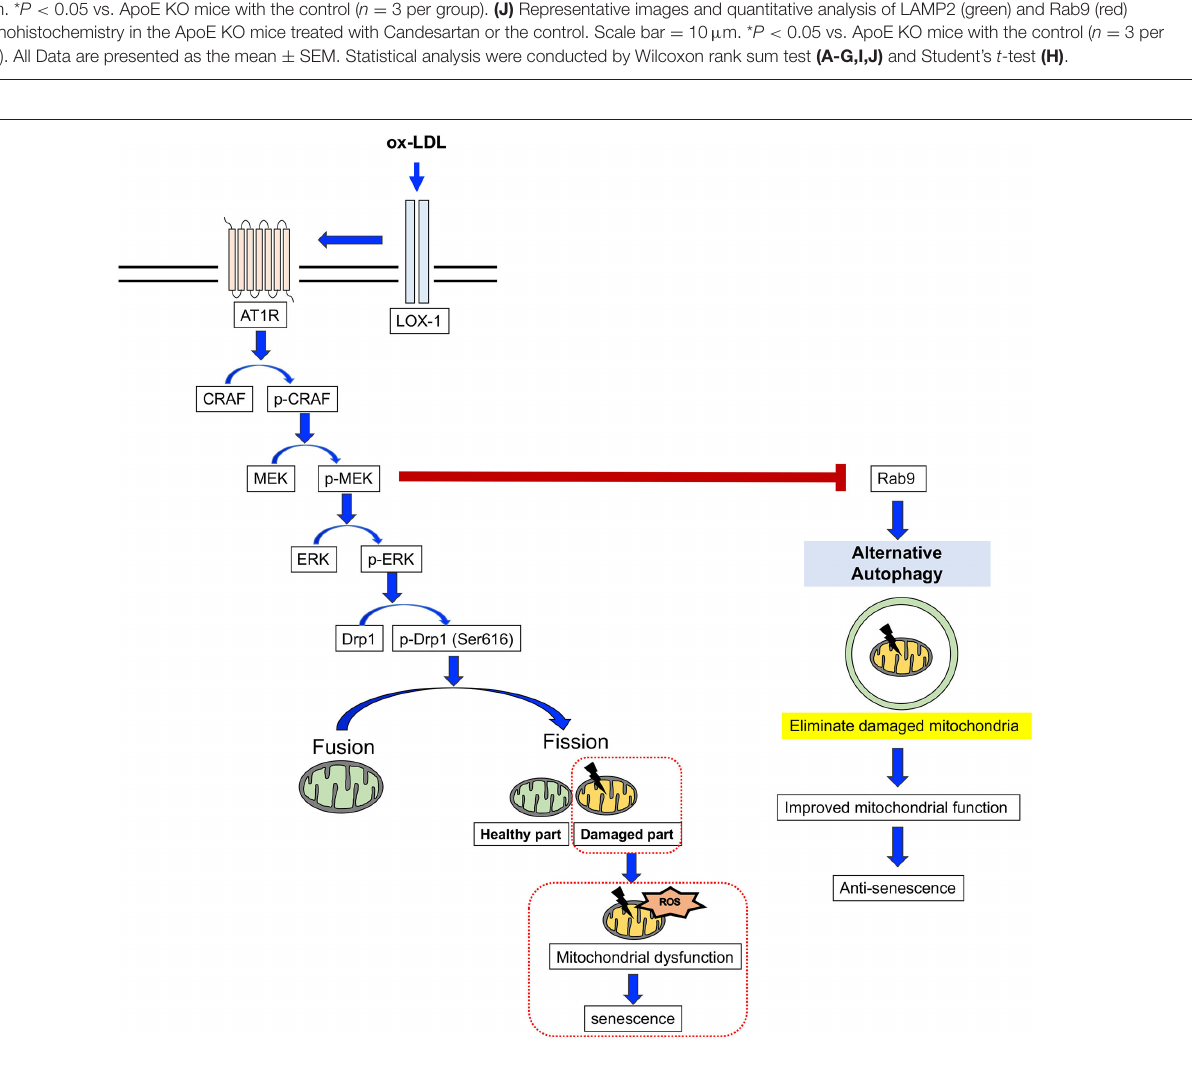
FIGURE 8 | Candesartan or the control. Scale bar = 1 µ m. * P < 0.05 vs. ApoE KO mice with the control ( n = 3 per group). (B) Immunoblots and quantitative analysis for Drp1, p-Drp1 (Ser616), p-Drp1 (Ser637), Mfn1, Mfn2, Opa1, and α -tublin in ApoE KO mice treated with Candesartan or the control. * P < 0.05 vs. ApoE KO mice with vehicle ( n = 3 per group). (C) Relative mitochondrial H 2 O 2 production in ApoE KO mice treated with Candesartan or the control. * P < 0.05 vs. ApoE KO mice with the control ( n = 3 per group). (D) Relative mitochondrial ATP production in ApoE KO mice treated with Candesartan or the control. * P < 0.05 vs. ApoE KO mice with the control (ApoE KO mice with Candesartan; n = 5, ApoE KO mice with the control; n = 3). (E) Representative images and quantitative analysis of Masson’s trichrome staining in ApoE KO mice treated with Candesartan or the control. Scale bar = 100 µ m. * P < 0.05 vs. ApoE KO mice with the control ( n = 3 per group). (F) Representative images and quantitative analysis of SA- β gal staining of arteries in ApoE KO mice treated with Candesartan or the control. * P < 0.05 vs. ApoE KO mice with the control vehicle (ApoE KO mice with Candesartan; n = 3, ApoE KO mice with the control; n = 4). (G) Immunoblots and quantitative analysis for p53, p21, and β -actin in ApoE KO mice with Candesartan or the control. * P < 0.05 vs. ApoE KO mice with the control ( n = 3 per group). (H) Electron microscopic images of mitochondrial autophagy in ApoE KO mice treated with Candesartan or the control. Scale bar = 1 µ m. ** P < 0.01 vs. ApoE KO mice with the control ( n = 14 per group). (I) Representative images of TOMM20 (green) and LAMP2 (red) immunohistochemistry in ApoE KO mice treated with Candesartan or the control. Scale bar = 10 µ m. * P < 0.05 vs. ApoE KO mice with the control ( n = 3 per group). (J) Representative images and quantitative analysis of LAMP2 (green) and Rab9 (red)